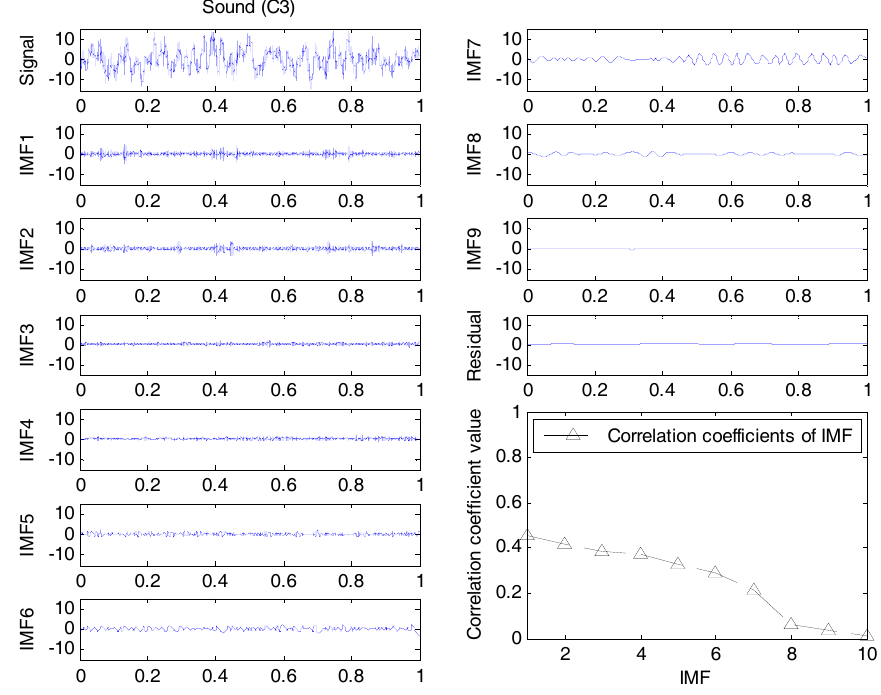
Figure 7. Example of ensemble empirical mode decomposition (EEMD) for decomposing sound signal